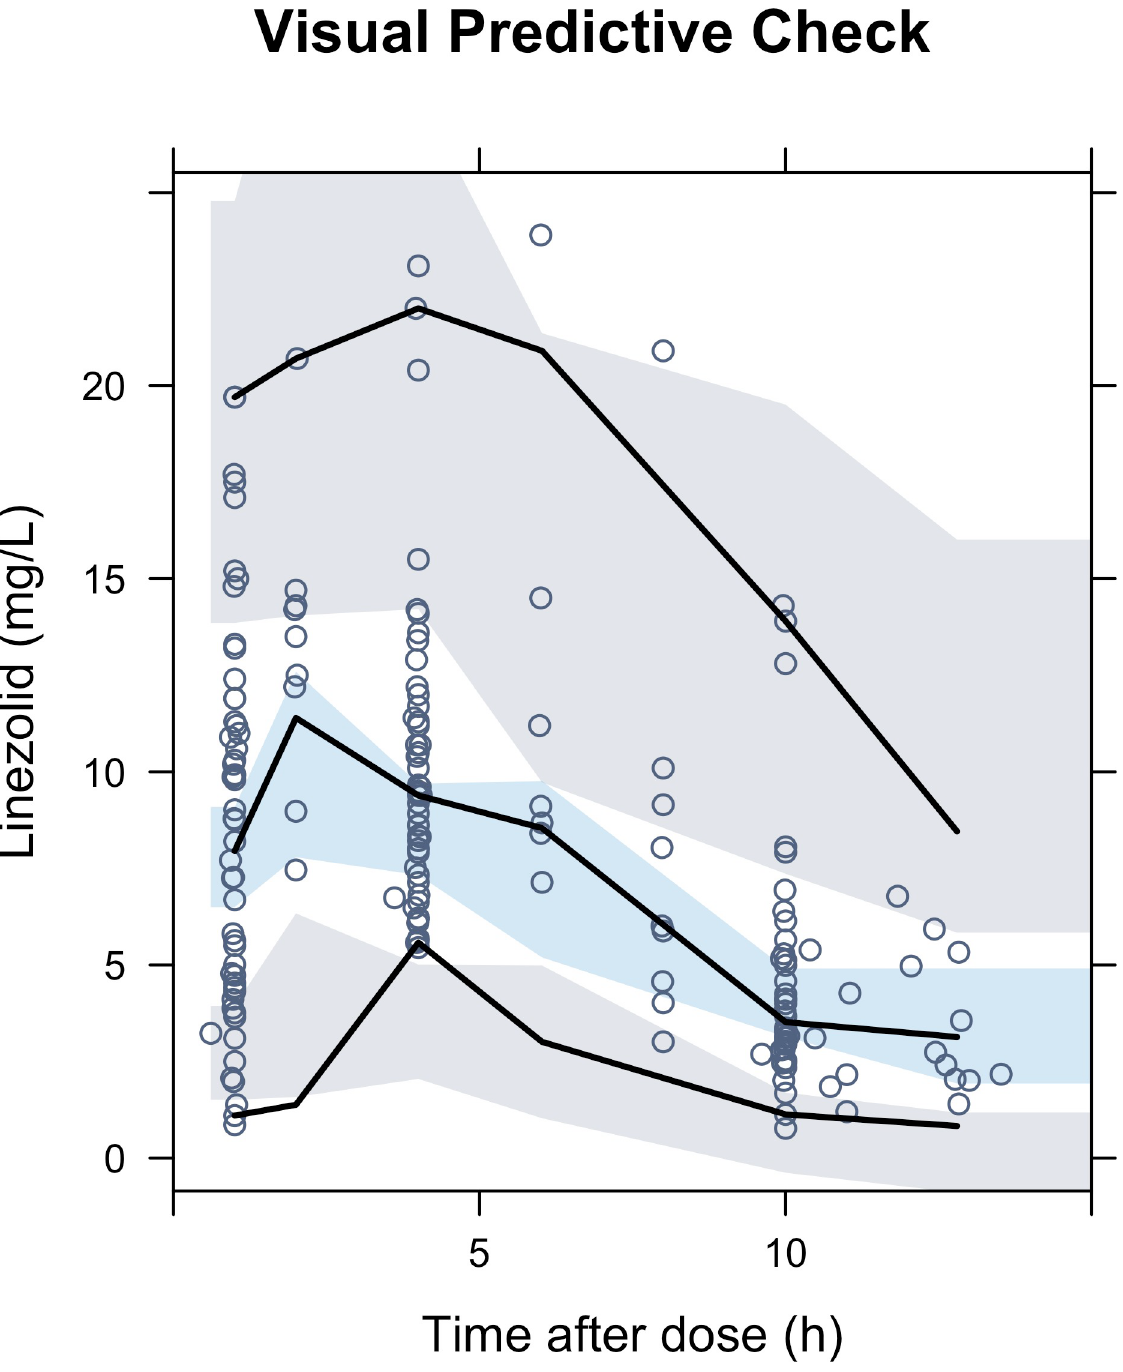
Fig 1. VPC corresponding to final linezolid pharmacokinetic model. Dots represent the observed linezolid concentrations; the solid lines correspond to the 5th, 50th, and 95th percentiles of these observations. Shaded areas are the model-predicted 95% confidence intervals for the median (blue), and 5th and 95th (grey) percentiles obtained from 500 simulated data sets. VPC, visual predictive